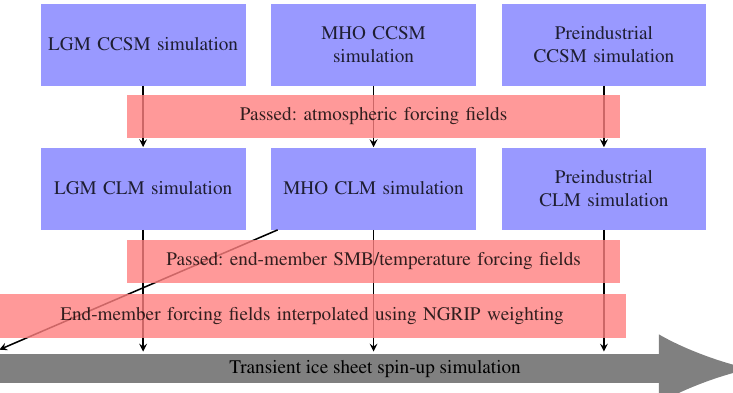
Figure 1. Work flow for the procedure described in this study. Atmospheric output from global model simulations is used to drive land-surface model simulations. These simulations generate the surface mass balance fields necessary to force the ice sheet model simulation (after ice core data-weighted interpolation between bounding end-member SMB and temperature fields and interpolation to the ice sheet geometry). Blue boxes: end-member simulations; red boxes: fields passed from one simulation to the next; grey arrow: final ice sheet simulation. Note use of MHO climate as a proxy for the LIG (diagonal arrow).